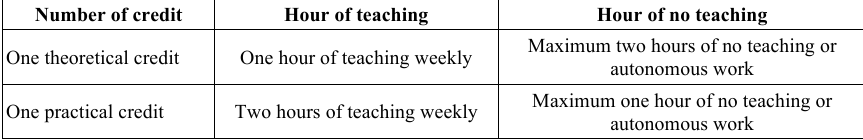
Table 5. Number of credit in comparison to hour of teaching and hour of no teaching Number of